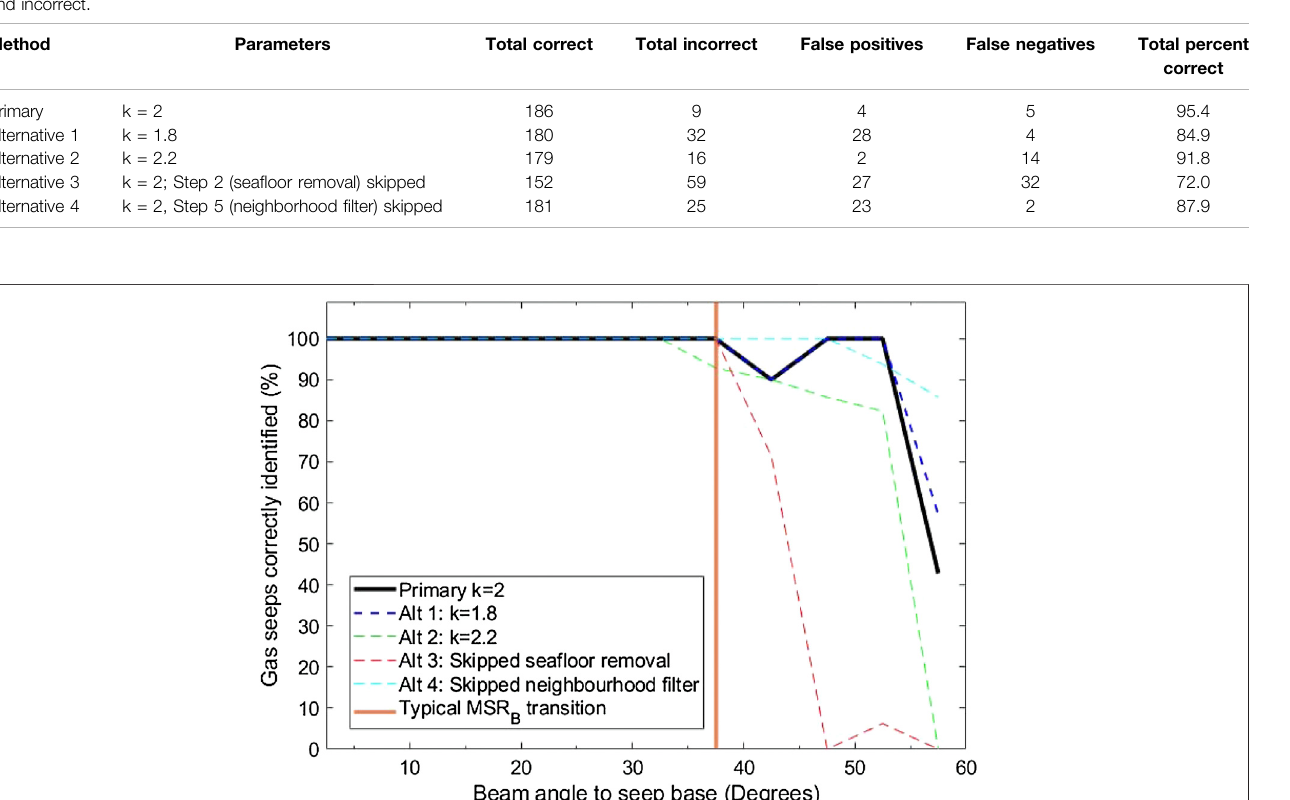
Frontiers in Remote Sensing |